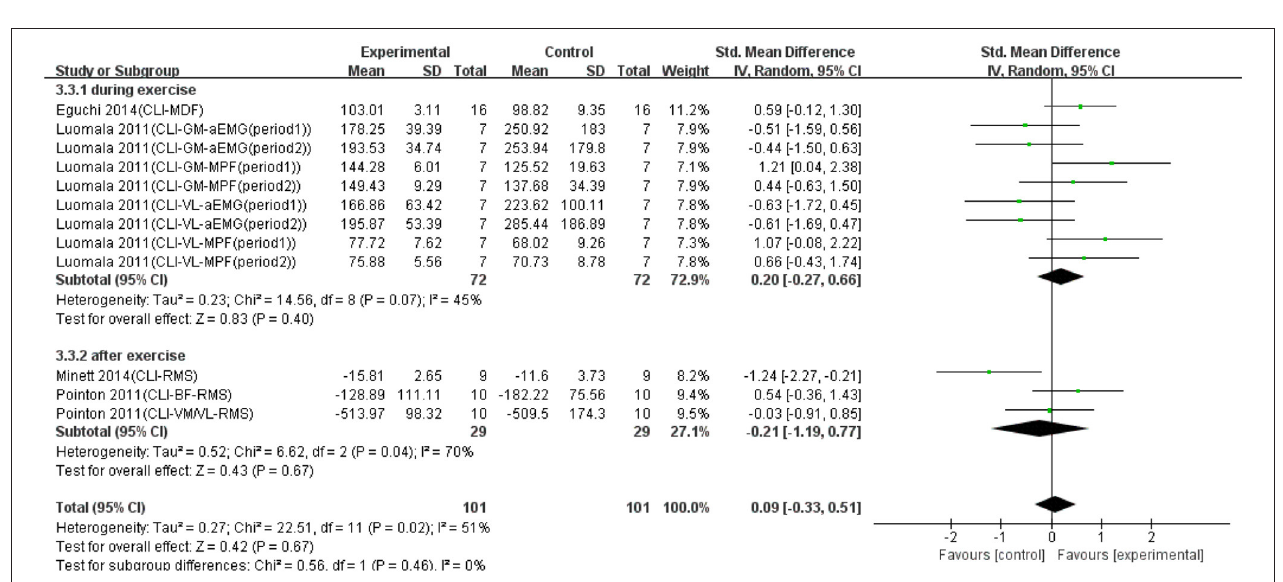
FIGURE 4 | The effectiveness of cooling (CLI) conducted at different time points on electromyography (EMG) signals of exercise-induced muscle fatigue.